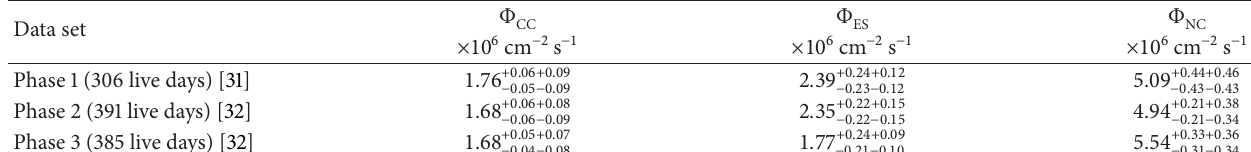
Table 4: Fluxes of 8 B solar neutrinos measured by SNO in the three phases of the data taking.